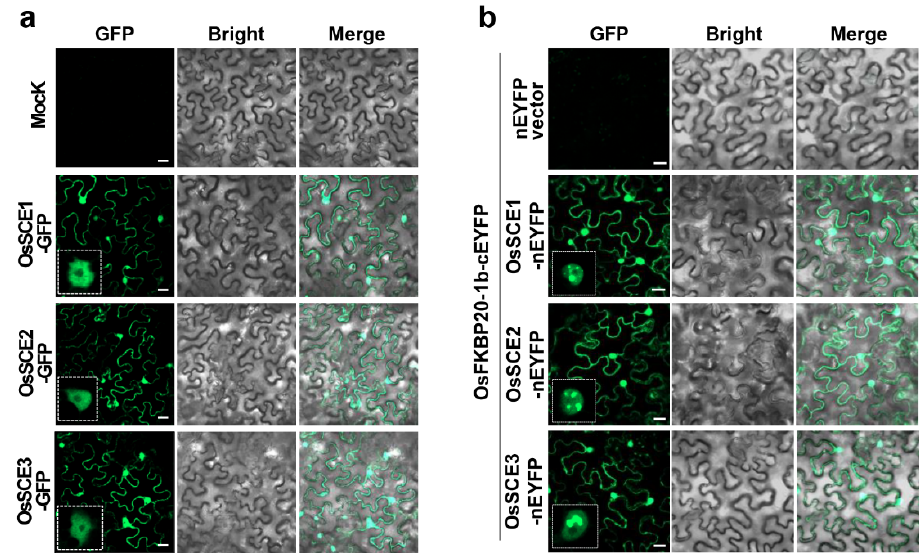
Figure 1. Interaction of OsFKBP20-1b with OsSCEs and the reconstituted SUMOylation assay. ( a ) Subcellular localization of OsSCE1-, OsSCE2-, and OsSCE3-GFP proteins. ( b ) BiFC assay of OsFKBP20-1b with OsSCEs. OsSCE constructs were cloned into pSPYNE (nEYFP) vector, and OsFKBP20-1b was cloned into pSPYCE (cEYFP) vector. Each construct was transformed into A. tumefaciens (GV3101) and infiltrated to leaves of 4-week-old N. benthamiana . Two days after infiltration, the leaves were observed using a confocal microscope. Bar = 50 μ m.